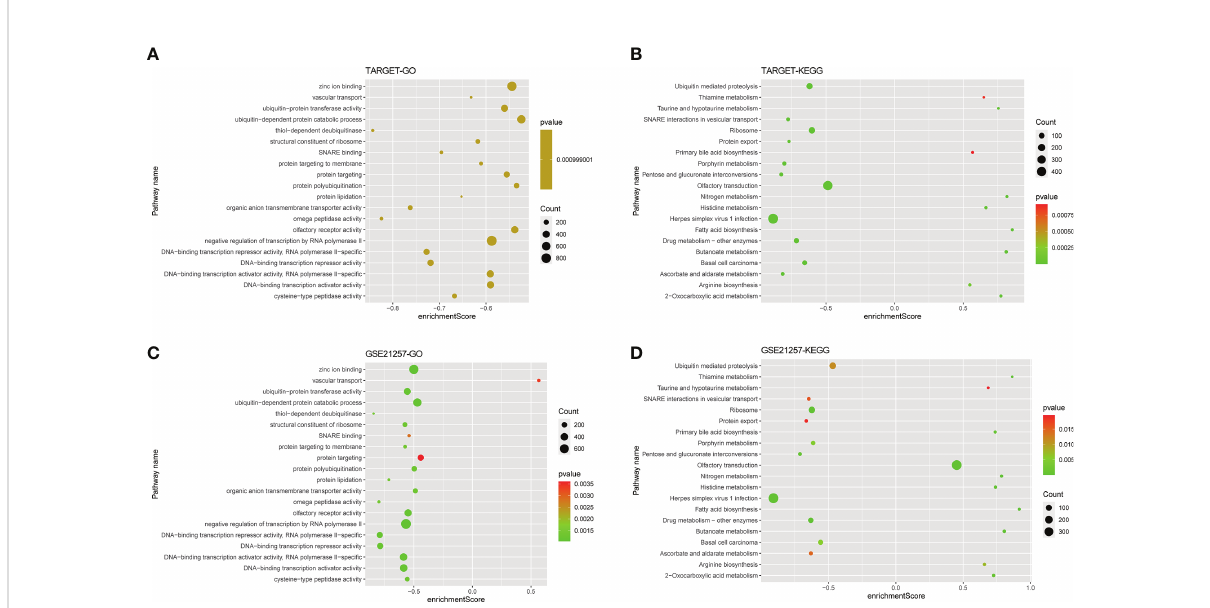
FIGURE 7 Gene function enrichment analysis. (A, B) The bubble plot showing the top twenty KEGG analysis enriched signaling pathways and GO analysis enriched biological processes in the training cohort. (C, D) The bubble plot showing the top twenty KEGG analysis enriched signaling pathways and GO analysis enriched biological processes in the validation cohort.